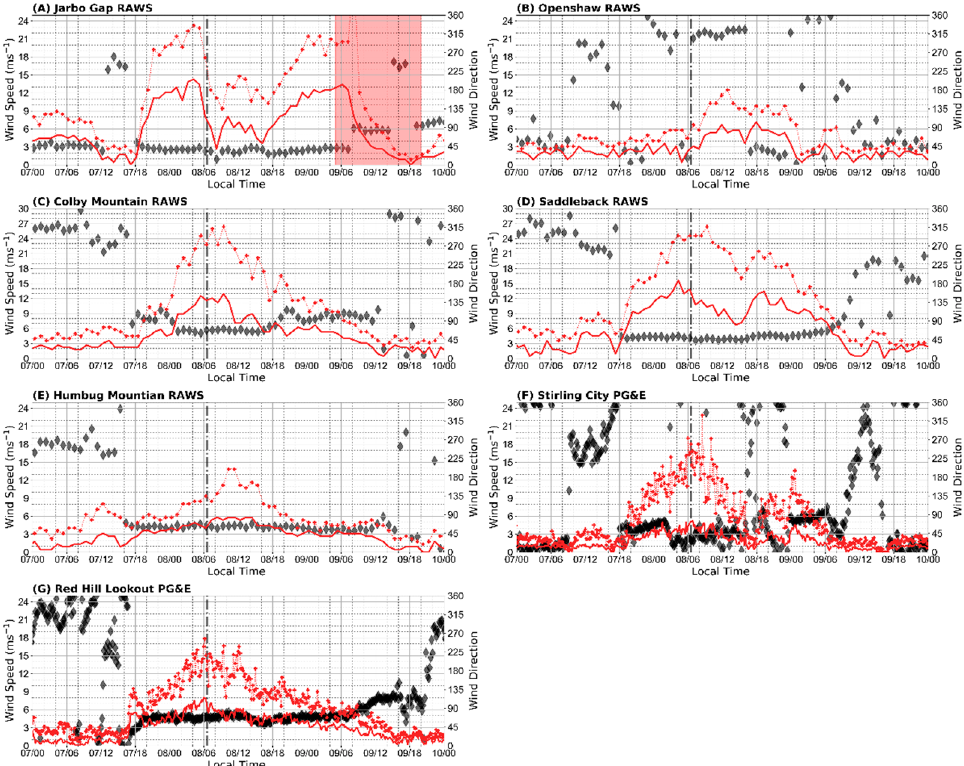
Figure 7. Time series of wind speed (red) and wind direction (black diamonds), and gusts (red dashed line and “ + ”) for each weather station, ( A ) Jarbo Gap RAWS, ( B ) Openshaw RAWS, ( C ) Colby Mountain RAWS, ( D ) Saddleback RAWS, ( E ) Humbug Mountain RAWS, ( F ) Stirling City PG&E, ( G ) Red Hill Lookout PG&E. The approximate ignition time is indicated by vertical dashed line. The red box in ( A ) indicates period of questionable data as denoted by